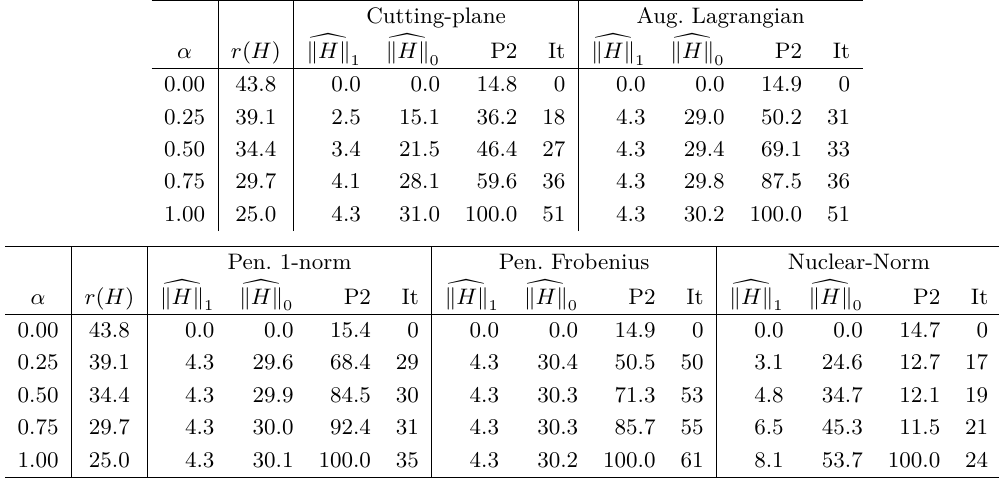
Table 2 Trade-off between norms and rank for ah-symmetric generalized inverses Cutting-plane Aug.